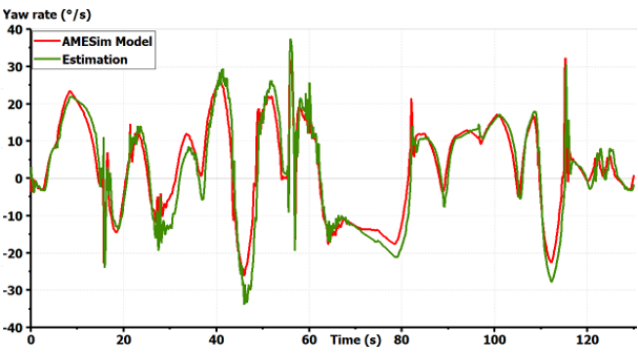
Figure 11. Validation of the vehicle model: yaw rate